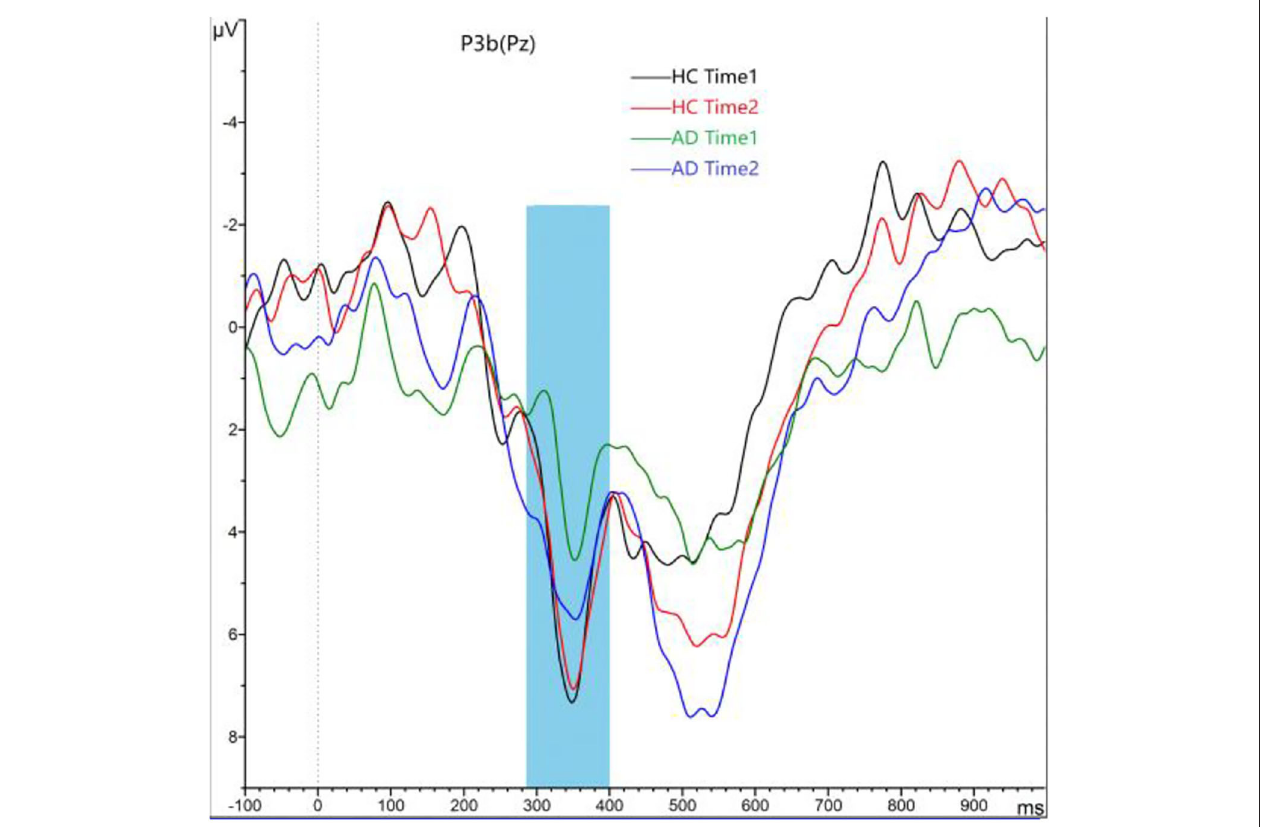
FIGURE 4 | Grand averaged P3b was elicited by a three-stimulus auditory oddball paradigm for the alcohol dependence (AD) group (purple lines and green lines) and the healthy control (HC) group (black lines and red lines) at time 1 and time 2. The P3b was presented within a 280- to 650-ms latency window at the Pz electrode site. The gray area is